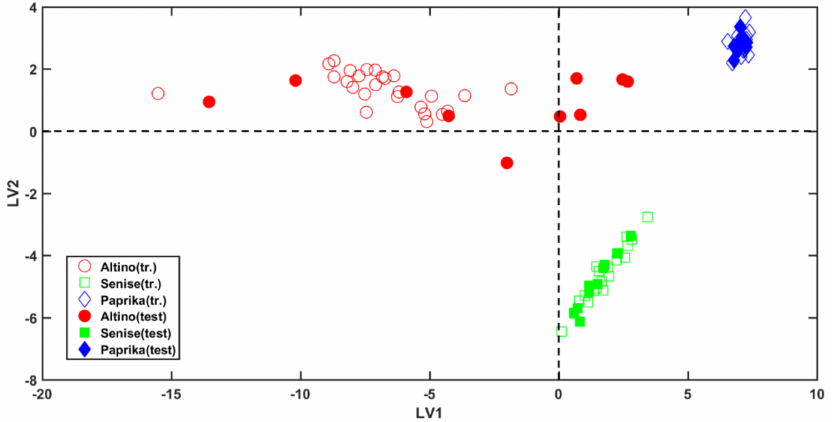
Figure 2. PLS-DA analysis: Score Plot. Empty and filled symbols represent training (tr.) and test samples, respectively.